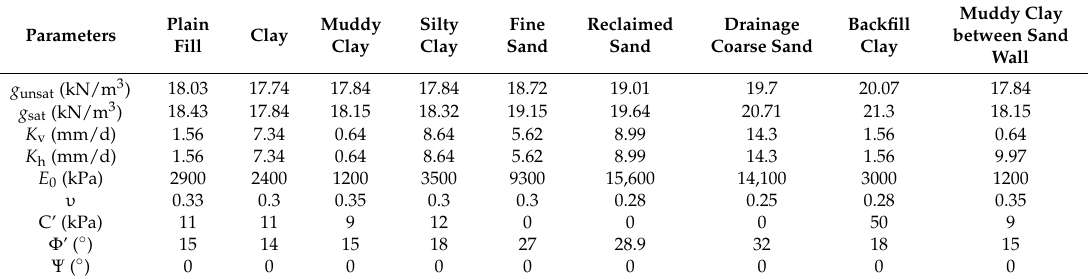
Table 5. Mohr coulomb model parameters.